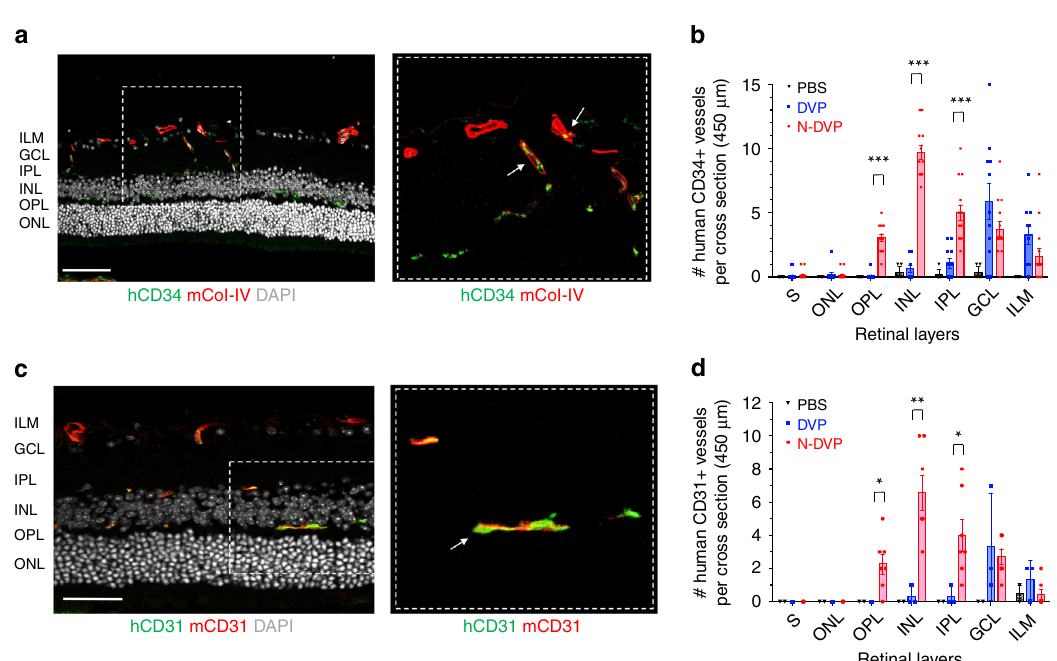
Fig. 7 Migration and vascular engraftment of primed vs. naïve DVP into ischemia-injured blood vessels of the neural retina. Cross-sectioned retinae of I/R-injured eyes of NOG mice were immunostained with either human CD34 ( a , b ; hCD34) or human CD31 ( c , d ; hCD31) antibodies 2 weeks following DVP vs. N-DVP injections. Antibodies for murine collagen type-IV (mCol-IV) were also employed to detect murine blood vessel basement membrane, and murine CD31 (mCD31) detected murine endothelium. The number of b human CD34 + or d human CD31 + cells detected within transverse layers of the murine neural retina (per 450 μ m retinal cross section) was quantitated with imaging software. Each data point represents a replicate individual 450 μ m retinal cross section that was analyzed from I/R- treated eyes injected with saline (PBS), primed DVP or N-DVP. Human CD34 + or human CD31 + endothelial cell engraftment was enumerated in each distinct layer of neural retina shown; only N-DVP migrated into the inner nuclear layer (INL) while most of the primed DVP remained primarily in the super fi cial ganglion cell layer (GCL). ILM: inner limiting membrane, IPL: inner plexiform layer, outer nuclear layer (ONL), OPL: outer plexiform layer, S: segments. All scale bars = 50 μ m. Each individual quantitation shown is an independent experimental measurement with (standard error of mean) SEM from an individually-immunostained cryosection for each of the three groups of injected mouse eyes (i.e., saline-PBS ( n = 8), DVP ( n = 3, CD31; n = 11, CD34), N-DVP ( n = 7, CD31; n = 14, CD34). *** p < 0.001; ** p < 0.01; * p < 0.05 (multiple unpaired t